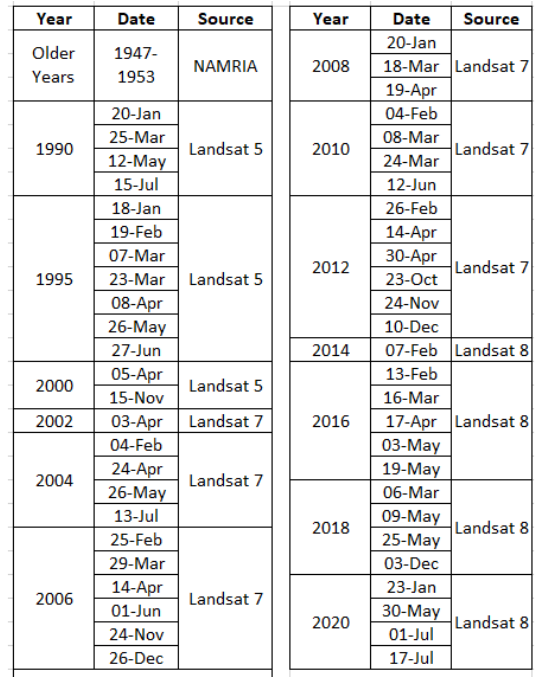
Table 1. Dataset Summary.